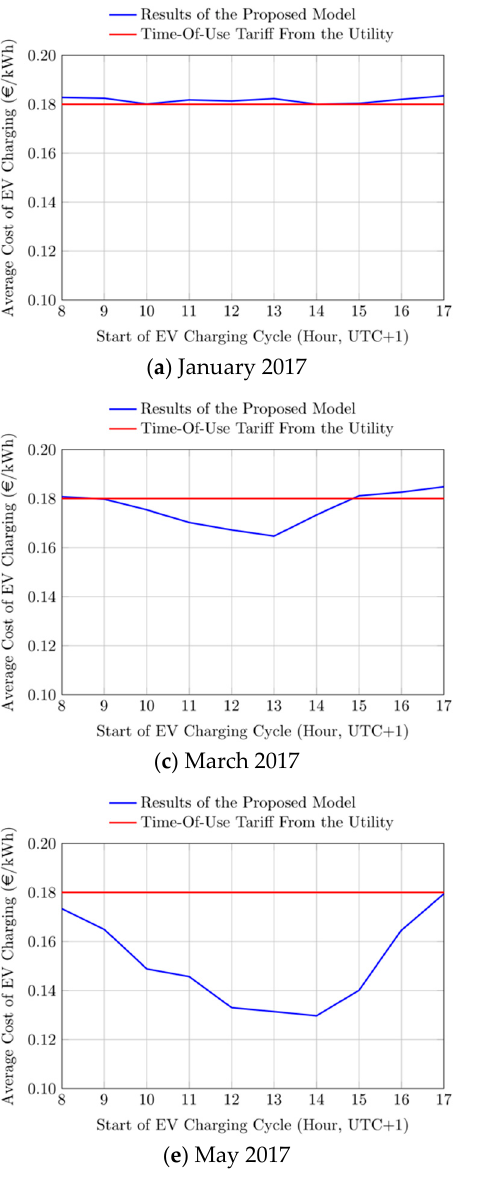
Figure 8. Monthly average cost of electric vehicle (EV) charging (€/kWh) from January to June 2017, as depicted from sub-figure ( a ) to sub-figure ( f ), respectively. The computed EV charging cost for each hour (blue line), is compared to the time-of-use (TOE) electricity tariff applied to the amount of energy purchased from the grid (red line). UTC: Universal Time Coordinated.